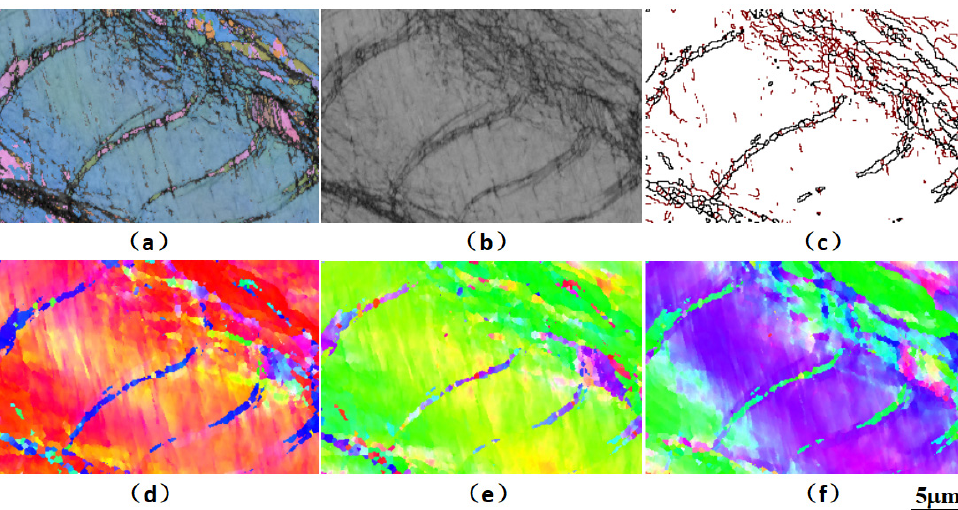
Figure 18. EBSD analysis results of microstructure near the fracture surface of the fatigue failure specimen of the SLM HEA (the detection area is the white dotted frame area in Figure 16a): p.( a ) comparison of all Euler diagrams and diffraction bands, ( b ) diffraction band comparison chart, ( c ) large angle (>15° black line) and small angle (<15° and >5° red line) grain boundary diagram, ( d ) IPF_X inverse pole figure, ( e ) IPF_Y inverse pole figure, ( f ) IPF_Z inverse pole figure.